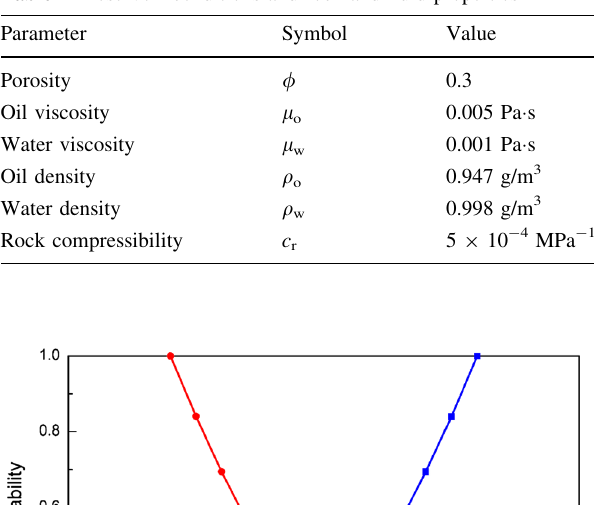
Table 1 Reservoir conditions and rock and fluid properties